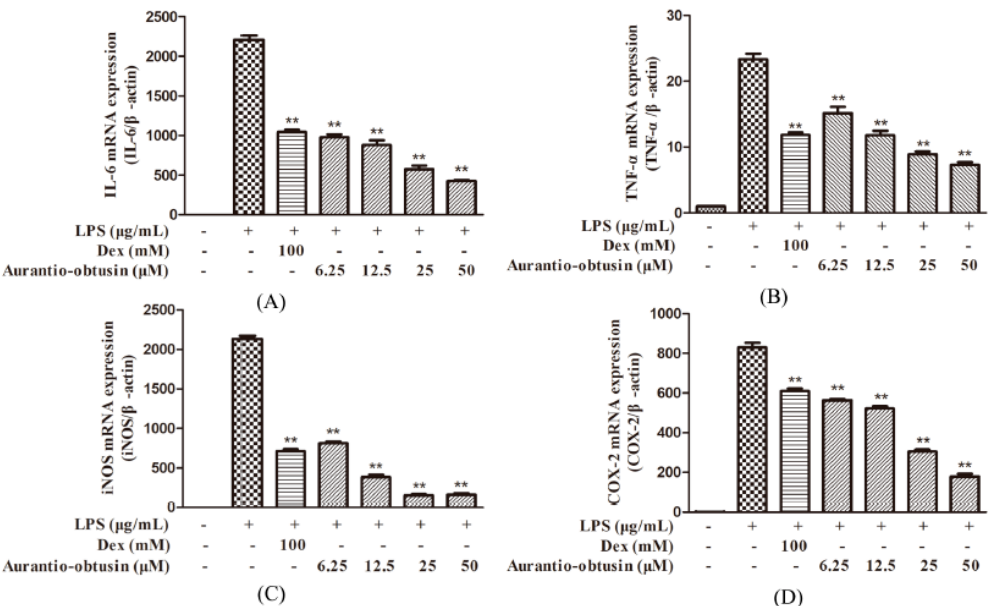
Figure 5. Effect of aurantio-obtusin on LPS-stimulated mRNA expression of IL-6, TNF- α , iNOS, and COX-2. RAW264.7 cells were pre-incubated with various concentrations of aurantio-obtusin (6.25–50 µ M) for 2 h followed by stimulation with LPS (0.2 µ g/mL) for 24 h. The mRNA expression of IL-6 ( A ), TNF- α ( B ), iNOS ( C ) and COX-2 ( D ) was analyzed using Real-time RT-PCR. The data are presented as mean ± SDs ( n = 3), ** p < 0.01 represent significance when compared to LPS-only treated